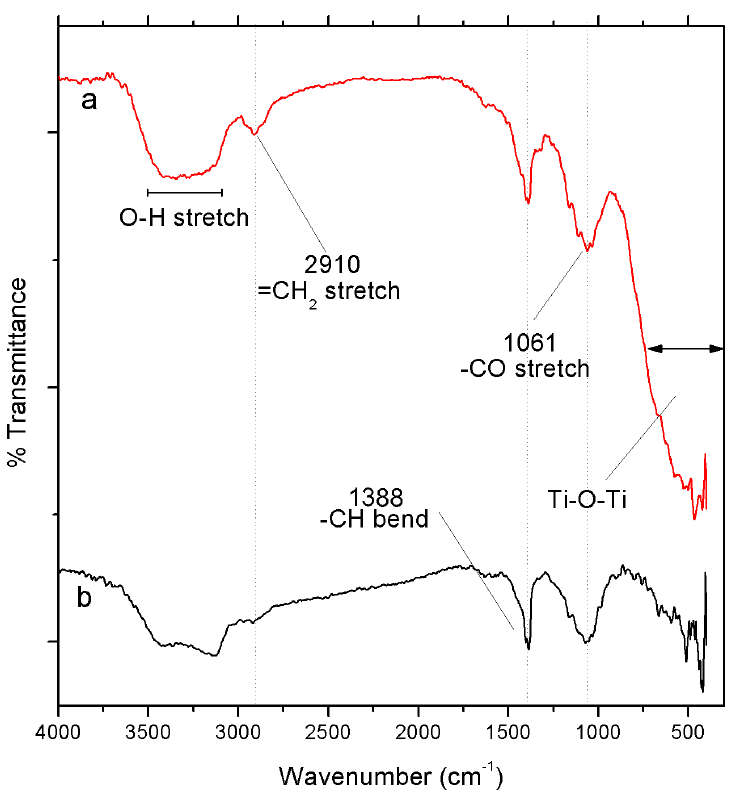
Figure 4. FTIR specta of (a) TiO 2 –fCNTs and (b) fCNTs.